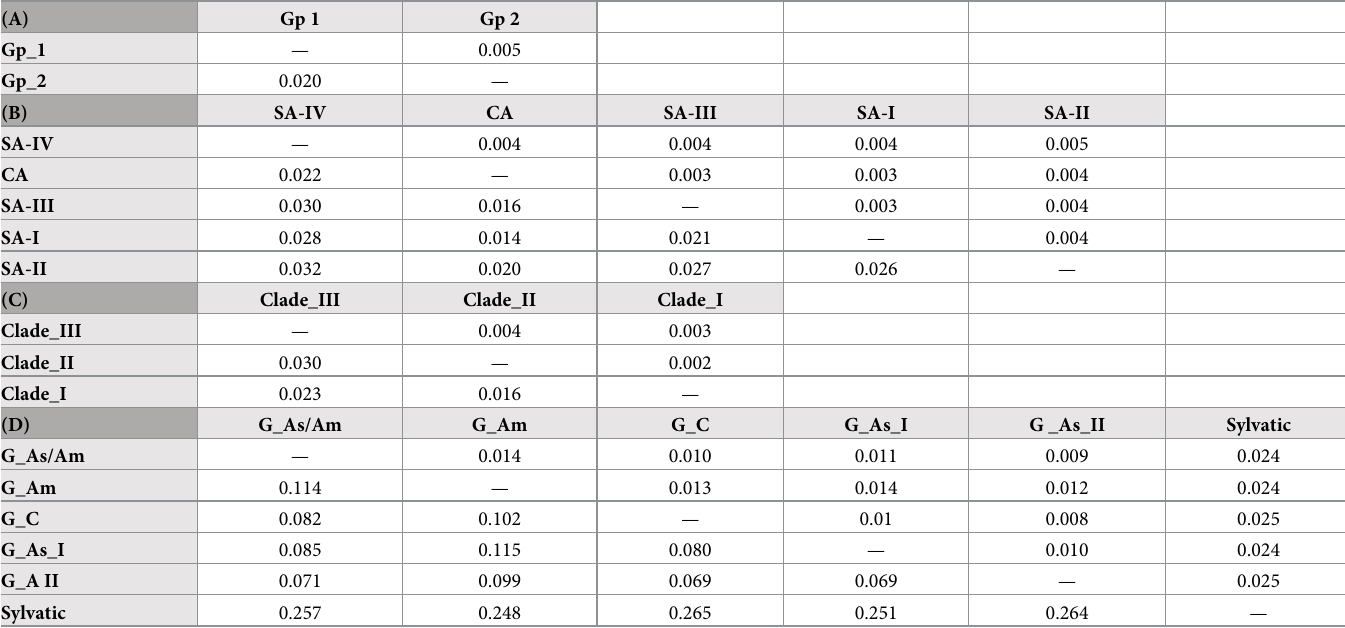
Table 3. Diversity of nucleotides in Asian–American genotype of